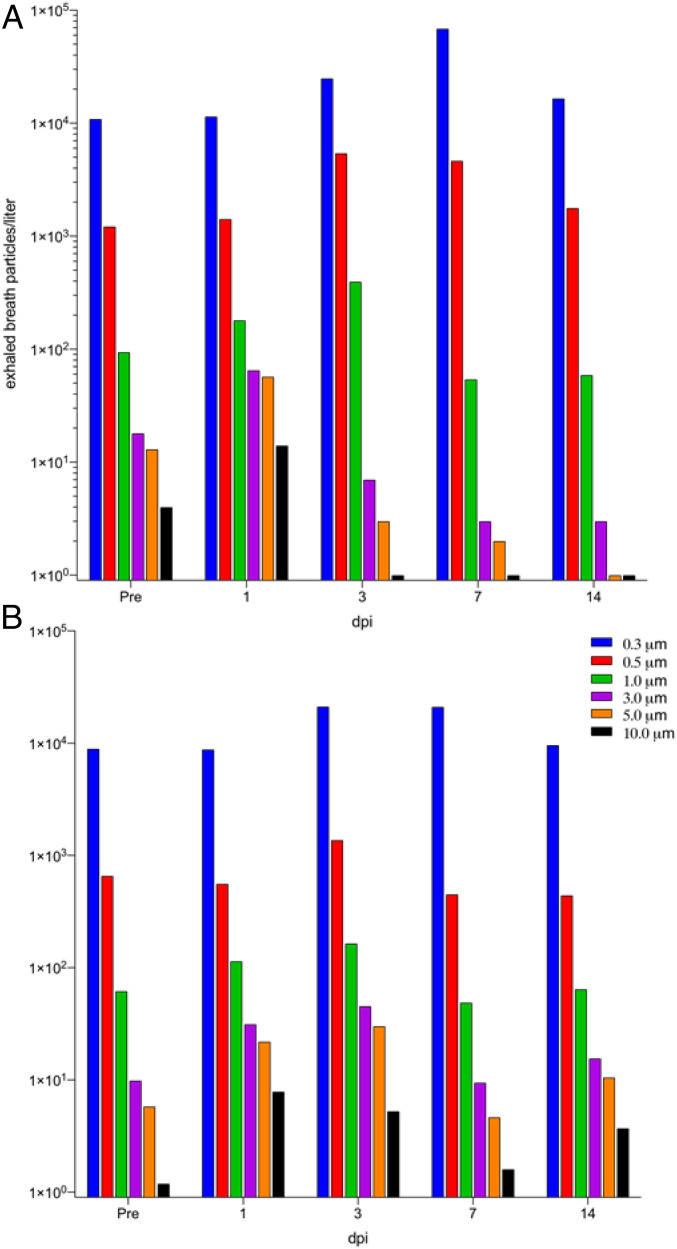
Exhaled breath particles and corresponding particle size distributions in experimentally infected (A) rhesus macaques (RM) and (B) African green monkeys (AGM); dpi, days postinfection.